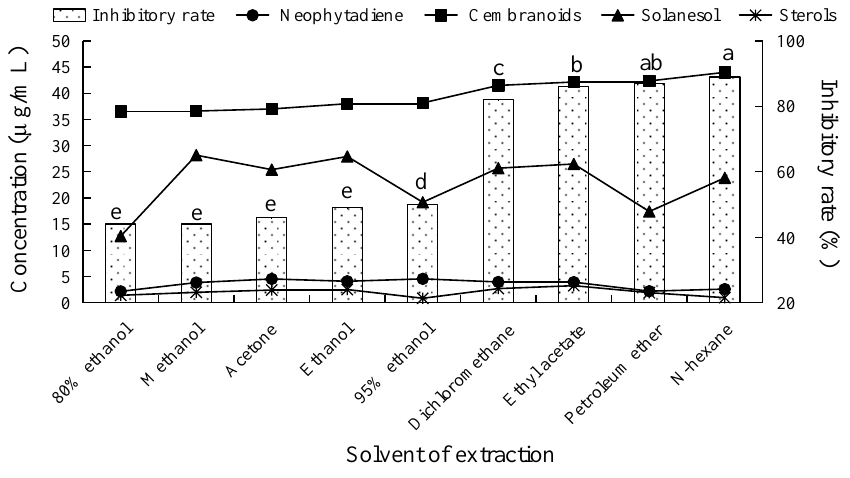
Figure 1. Inhibitory rate against V. mali and the concentration of terpenes of tobacco leaf extracts obtained using different solvents. Columns with different letters represent significantly different extraction solvents according to Duncan’s multiple range tests at p < 0.05.